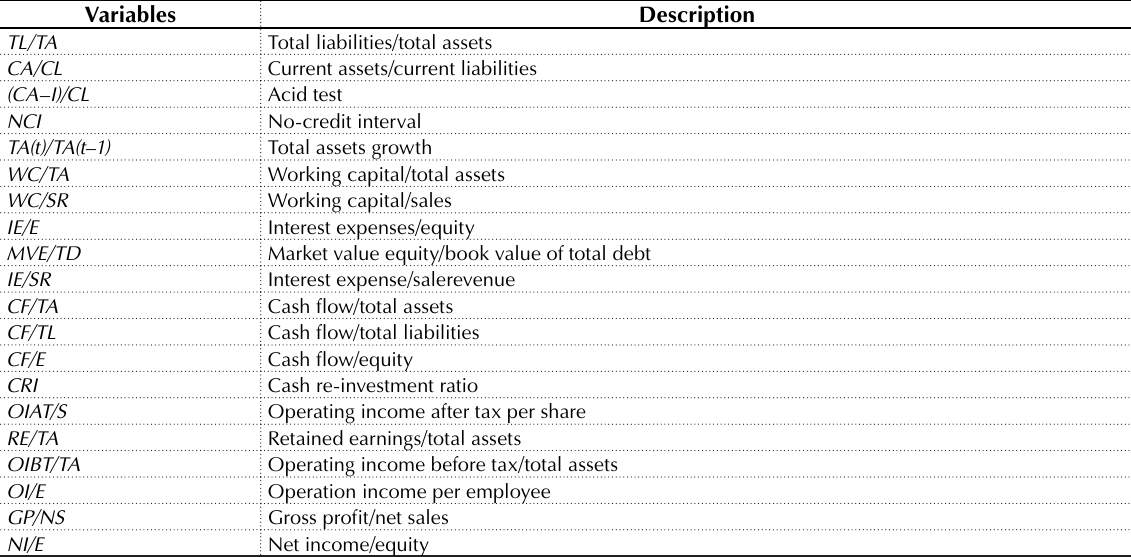
Source: Adapted by Lin et al.